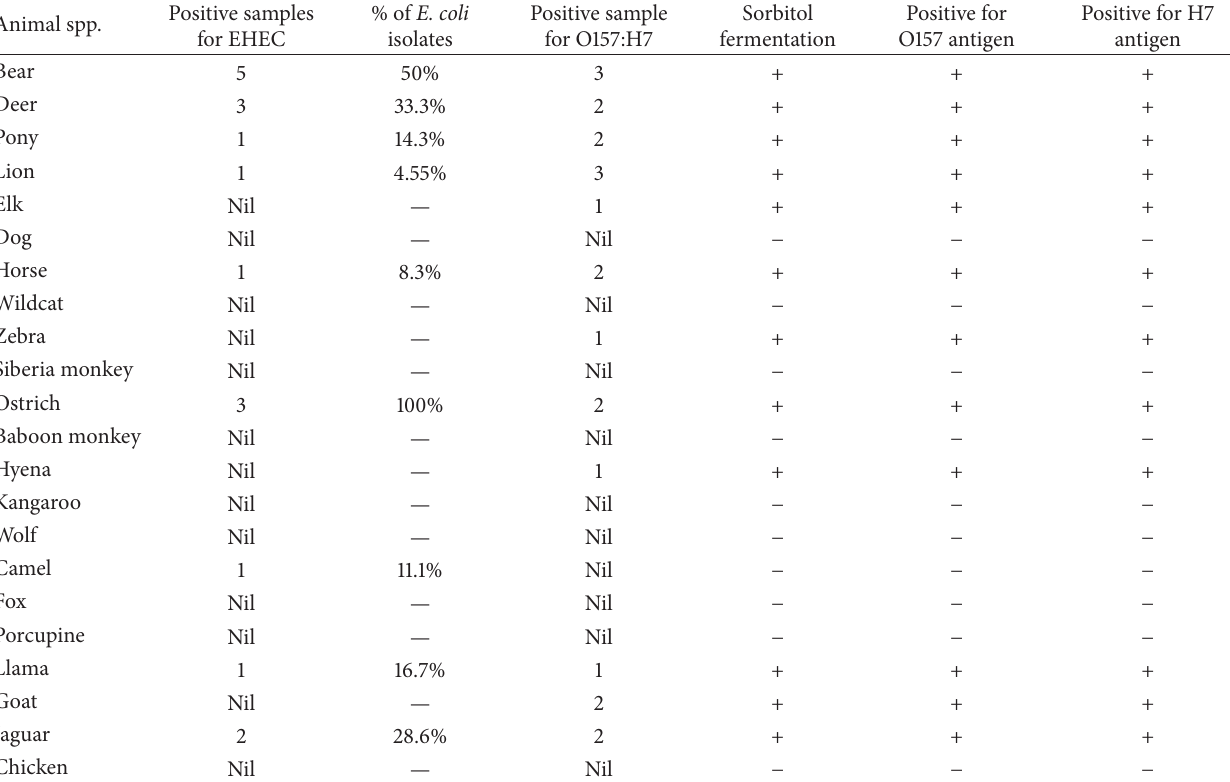
Table 2: The percentage of EHEC E. coli isolate and E. coli O157:H7 with its characteristic features. Animal